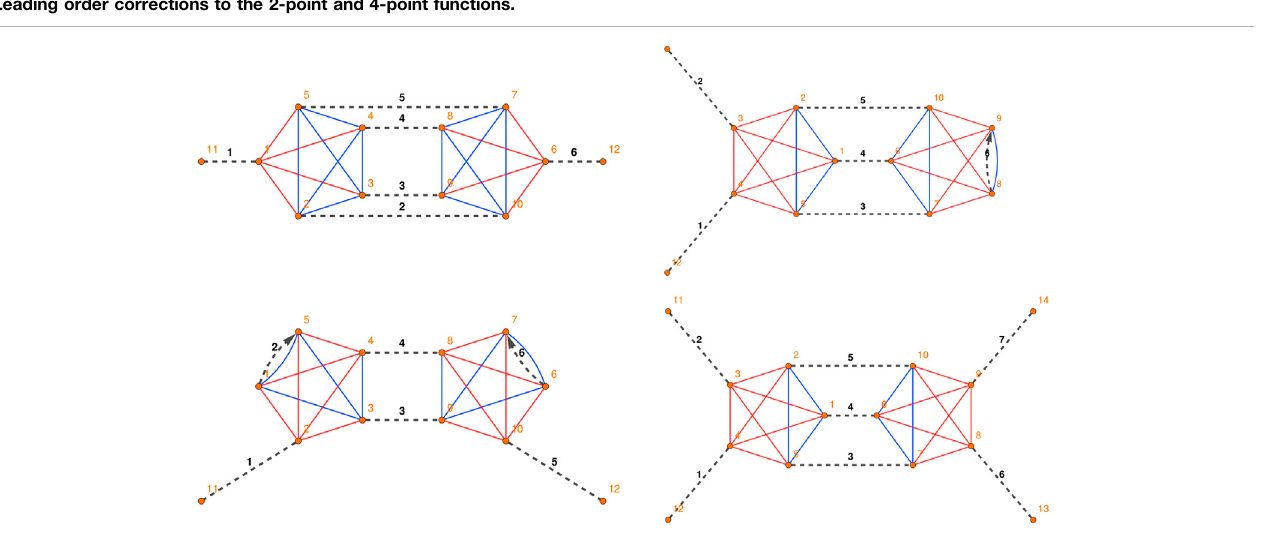
TABLE 1 | The 1PI diagrams contributing to the LO expansion of the 2-point and 4-point functions W 2 and W 4 . Each GFT Feynman diagram is labeled according to the number of external edges, the number of vertices and the position in the list. For example, the fi rst graph on the left is called G 221 . The dashed lines represent the propagators. The solid lines denote the internal structure of each simplicial GFT vertex. Blue lines are associated to the internal faces, while red lines belong to the external ones. A face is a one-color alternating sequence of solid and dashed lines The labels for internal and external faces have not been shown. Leading order corrections to the 2-point and 4-point